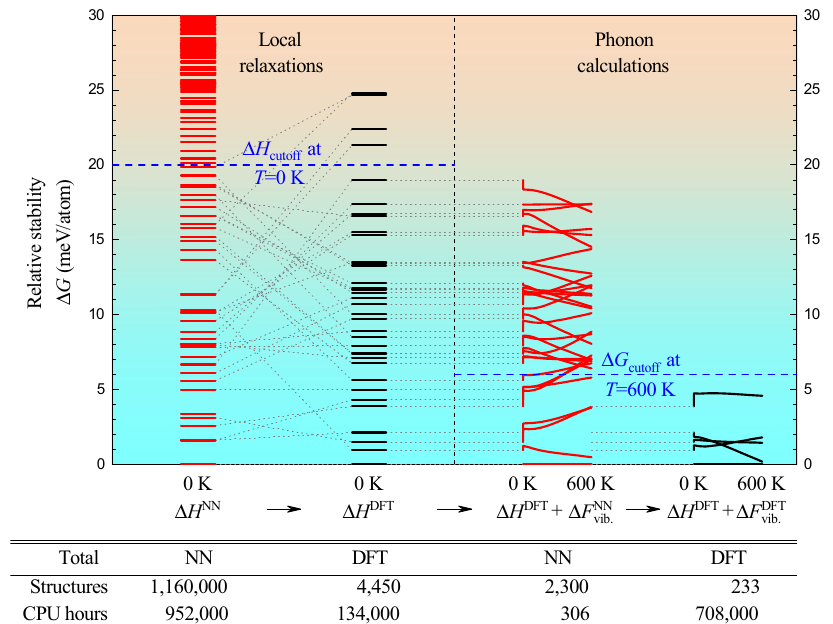
Fig. 2 An overview of the NN-guided identi fi cation of zero- T and high- T ab initio ground states. The fl owchart illustrates the selection of viable candidates following a representative evolutionary search performed for Li 18 Sn 4 unit cells at 0 GPa. The two sets on the left correspond to the lowest-enthalpy NN minima (in red) and the resulting reoptimized DFT minima (in black). The two subsets on the right show the relative Gibbs free energies in the 0 – 600 K range with the phonon entropy contributions calculated with the NN model (in red) and the DFT (in black). Every subset is referenced to the structure with the lowest enthalpy in the pool at the corresponding level of theory. The table at the bottom shows the tally of the structures examined and computational resources used in the full exploration of the Li-Sn